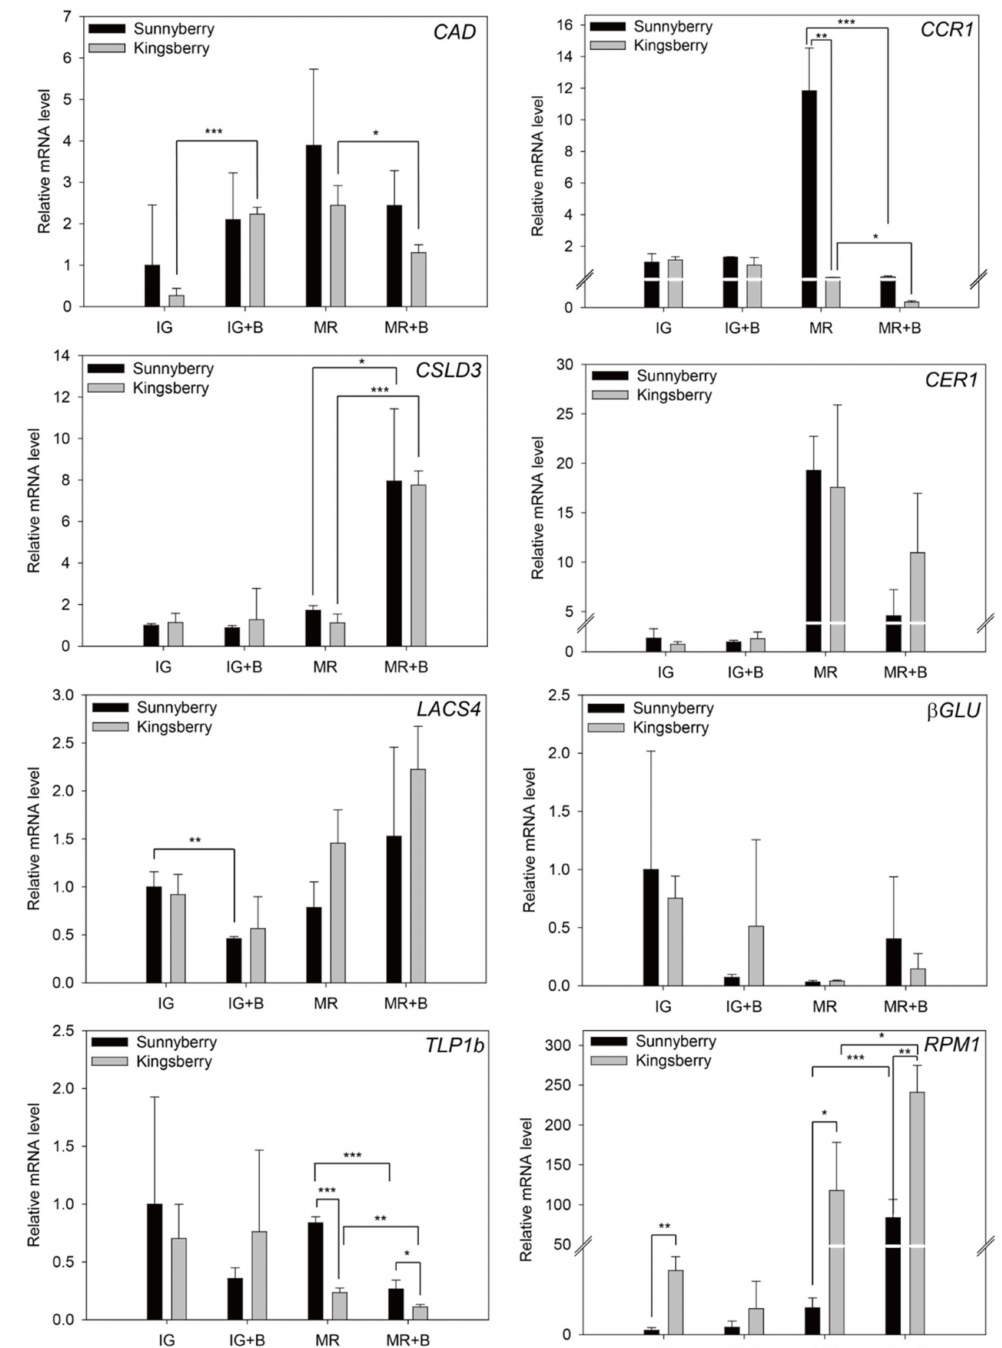
Figure 5. qPCR analysis of eight DEGs in “Sunnyberry” and “Kingsberry” strawberry fruit in the presence or absence of Botrytis cinerea inoculation. Relative mRNA levels of genes related to cell wall metabolism ( CAD , CCR1 , and CSLD3 ), cuticle biosynthesis ( CER1 and LACS4 ), and defense responses ( β GLU , TLP1b , and RPM1 ). β GLU , glucan endo-1, 3- β - glucosidase; CAD , cinnamyl alcohol dehydrogenase; CCR1 , cinnamoyl-CoA reductase 1; CER1 , protein ECERIFERUM 1; CSLD3 , cellulose synthase-like protein D3; IG, immature-green fruit without inoculation; IG + B, immature-green fruit at 5 days after inoculation; LACS4 , long-chain acyl-CoA synthetase 4; MR, mature-red fruit without inoculation; MR + B, mature-red fruit at 10 days after inoculation; RPM1 , disease resistance protein RPM 1-like; TLP1b , thaumatin-like proteins. Data are means ± SD for three biological replicates. Asterisks indicate statistically significant differences between cultivars. *, p < 0.05; **, p < 0.01; ***, p <